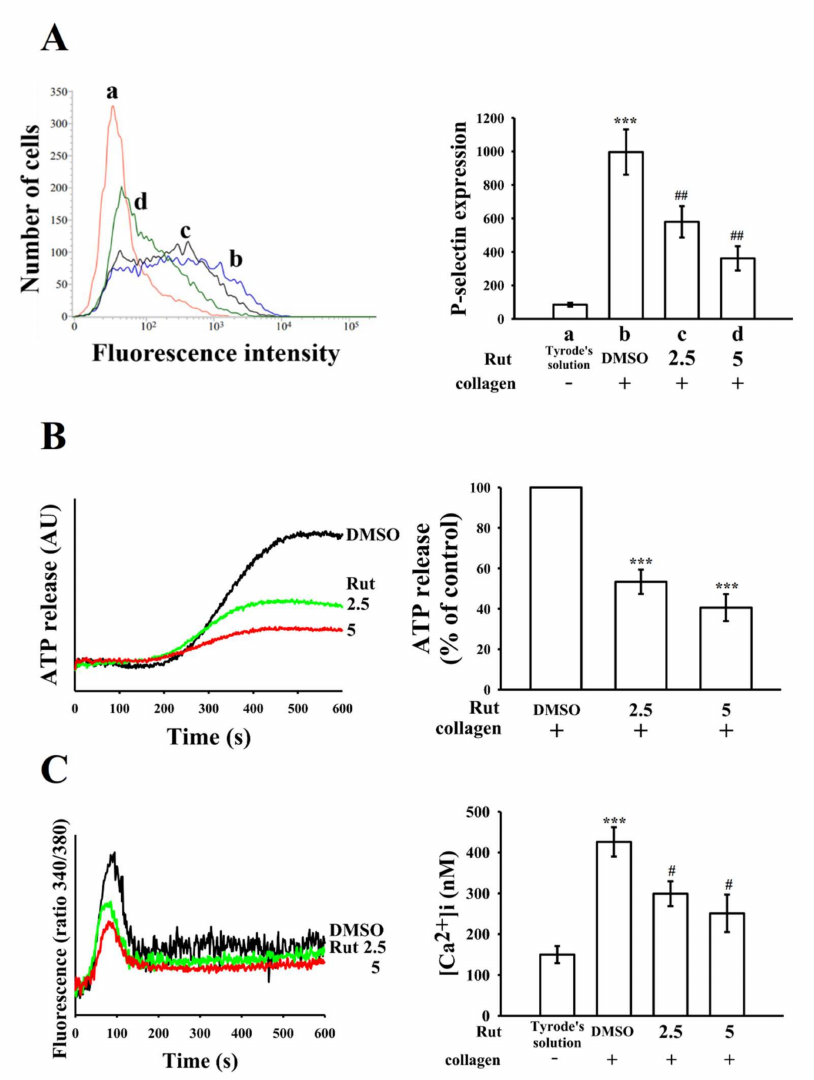
Figure 2. Inhibitory effects of Rut on surface P-selectin expression, adenosine triphosphate (ATP)-release reaction, and relative [Ca 2+ ]i mobilization in human platelets. Washed platelets (3.6 × 10 8 cells/mL) were preincubated with 0.1% DMSO or Rut (2.5 and 5 µ M), followed by the addition of collagen (1 µ g/mL) to trigger ( A ) surface P-selectin expression (a, resting control; b, collagen-activated; c, Rut 2.5 µ M; d, Rut 5 µ M), ( B ) ATP release (AU; arbitrary unit), and ( C ) relative [Ca 2+ ]i mobilization, as described in the Materials and Methods section. The corresponding statistical data are presented in the right panel of each figure. Data are presented as the mean ± standard error of the mean ( n = 4). ( A , C ) *** p < 0.001 compared with the resting control (Tyrode’s solution); # p < 0.05 and ## p < 0.01 compared with the 0.1% DMSO-treated group. ( B ) *** p < 0.001 compared with the 0.1% DMSO-treated